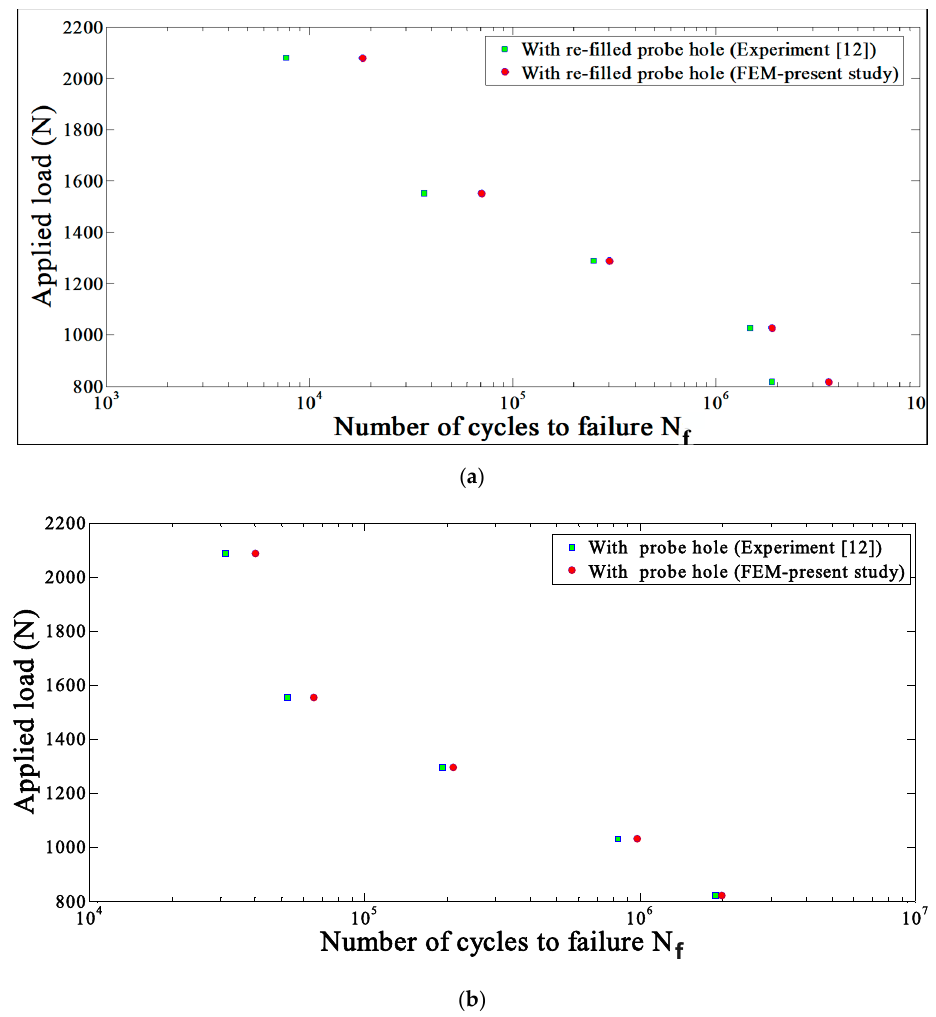
Figure 9. The maximum load applied to the structures versus the number of cycles to failure for both the experimental [12] and FEM studies with ( a ) re ‐ filled probe hole and ( b ) with probe hole for R = 0.1.